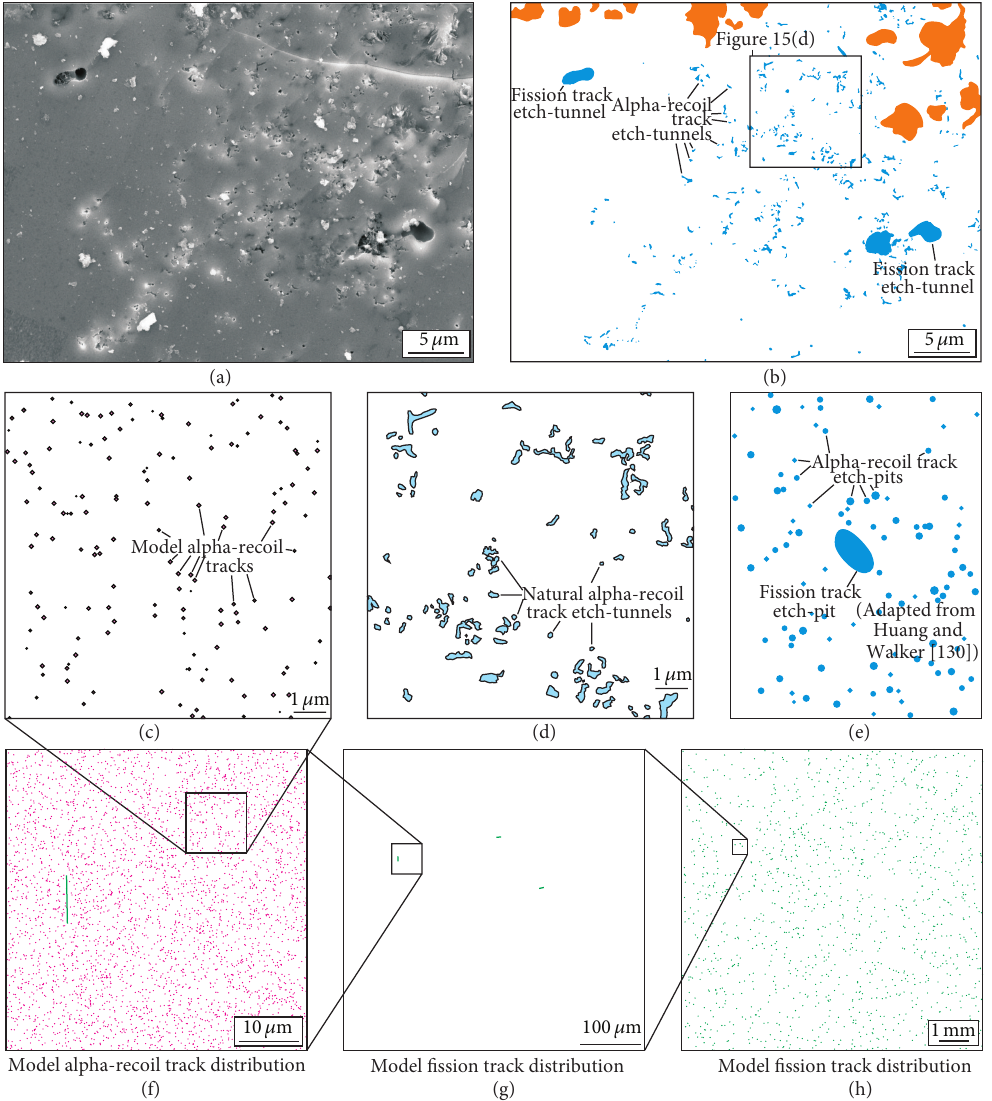
Figure 15: Comparison of theoretical modelling of radiation damage in DSDP 418A basaltic glass with the observed distribution of natural etch-tunnels at the glass-palagonite interface. (a) Representative SEM (secondary electron) image of the etch-tunnel zone (close-up from Figure 11(a)). (b) Porosity map (constructed from (a)) highlighting the distribution of fission track etch-tunnels (FTETs) and alpha-recoil track etch-tunnels (ARTETs) observed at the glass-palagonite interface. (c) Theoretical areal distribution of alpha-recoil tracks (ARTs) in DSDP 418A basaltic glass intersecting a hypothetical flat fracture plane through the glass (calculated using (1)). In this close-up theoretical plot (c), the individual model ARTs are plotted as randomly distributed 120nm diameter spheres, resulting in pink circles of varying size (up to 120 nm), depending on their depth relative to the plane of the page (i.e., flat fracture surface). (d) Close-up porosity map from (b), highlighting a representative region of the etch-tunnel zone that is predominated by ARTETs. Note the similarity in size and areal distribution of the natural ARTETs (d) with the theoretically modelled ARTs (c), indicating a causal relationship. Many of the ARTETs in (d) exhibit elongate anastamosing shapes, the result of seawater “etching out” several nearby alpha-recoil tracks in cumulative succession (see “step 10a” in the lower left panel of Figure 18). (e) Etch-pit map, showing the observed distribution of experimentally etched ARTs and one etched-out fission track, on the cleavage surface of a mica crystal (adapted from Figure 1(b) of Huang and Walker [130], no scale bar available). (f–h) Theoretical models of the present-day distribution of randomly distributed ARTs (pink) and fission tracks (green) intersecting a hypothetical flat fracture plane through DSDP 418A basaltic glass, as determined using (1) and (2). For clarity, ARTs are not shown in (g) and (h) because of their exceptionally high numbers. Note how in (f), one single large fission track is surrounded by a multitude of smaller ARTs, similar in nature to the bimodal size versus population distributions of experimentally etched ARTs and fission tracks in mica (e) and naturally formed ARTETs and FTETs in DSDP 418A basaltic glass (b), a key argument for the “radiation damage” origin of the ARTETs and FTETs in DSDP 418A basaltic glass (see Sections 3.4.2, 5.2, and 6.1 for discussion). Colours in (b) and (d): blue = ARTETs and FTETs; white = fresh basaltic glass; orange = palagonite. Colours in (c), (f), (g), and (h): white = fresh basaltic glass not affected by radiation damage; pink = model ARTs; green = model fission tracks (randomly oriented lines in (f) and (g); dots in (h)). Colours in (e): white = fresh cleavage surface of mica; blue = ART etch-pits and one fission track